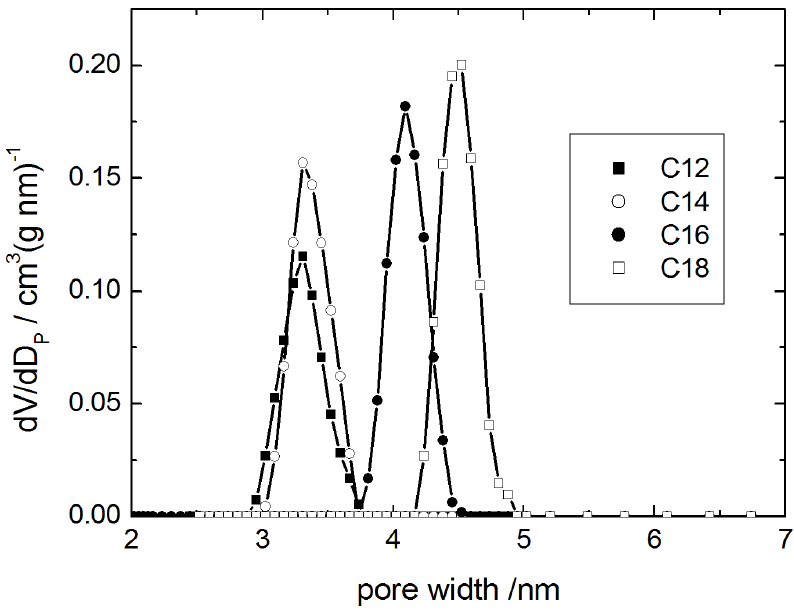
Figure 7. Pore width distribution calculated using the DFT model (cylindrical pore) for transformation products obtained using alkyltrimethylammonium-based surfactants with alkyl chain lengths of C12, C14, C16 and